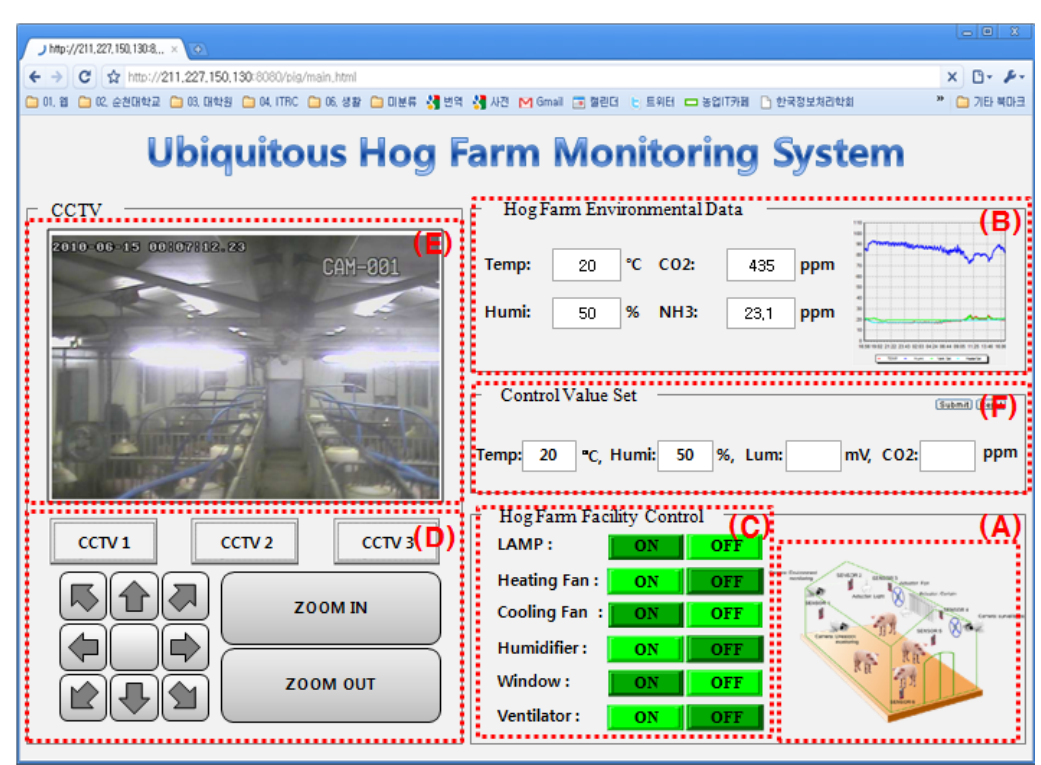
Figure 15. Ubiquitous Hog Farm Monitoring System GUI.